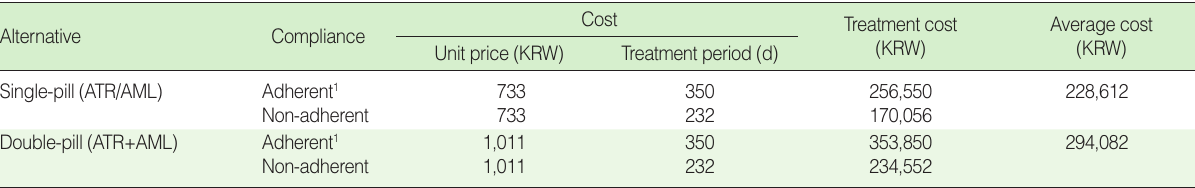
Table 2. Drug cost for each medication regimen